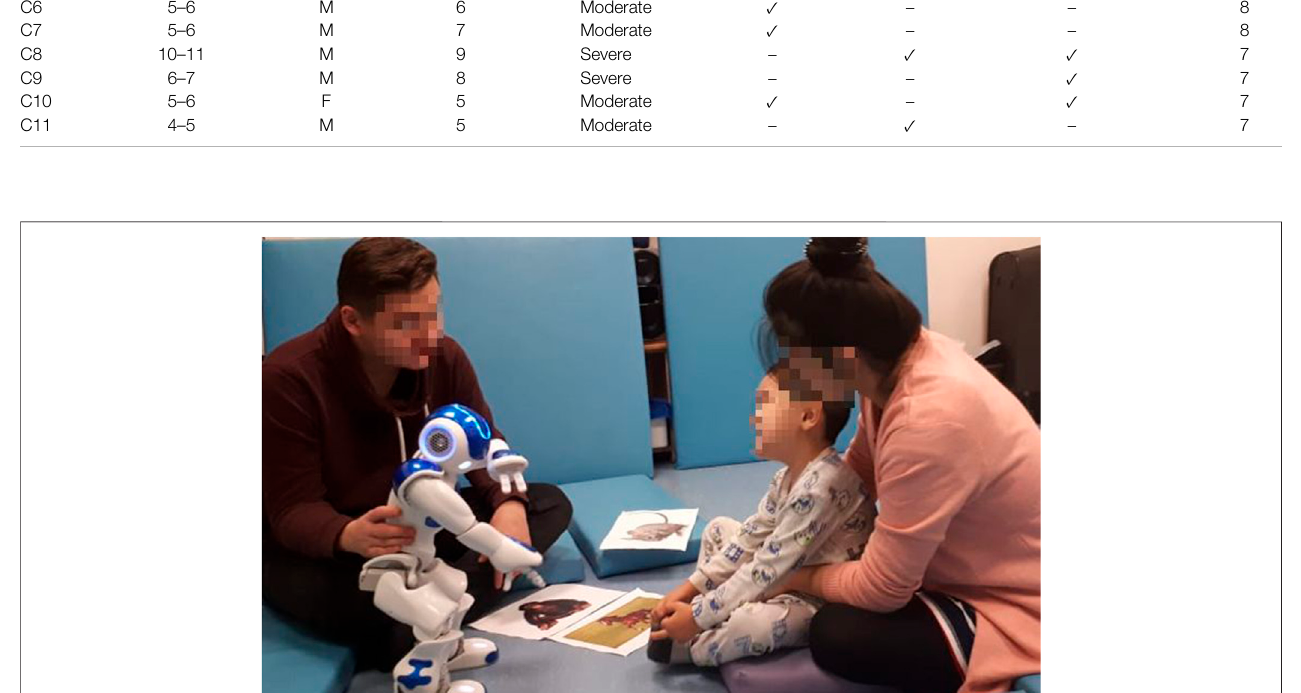
FIGURE 1 | Experimental